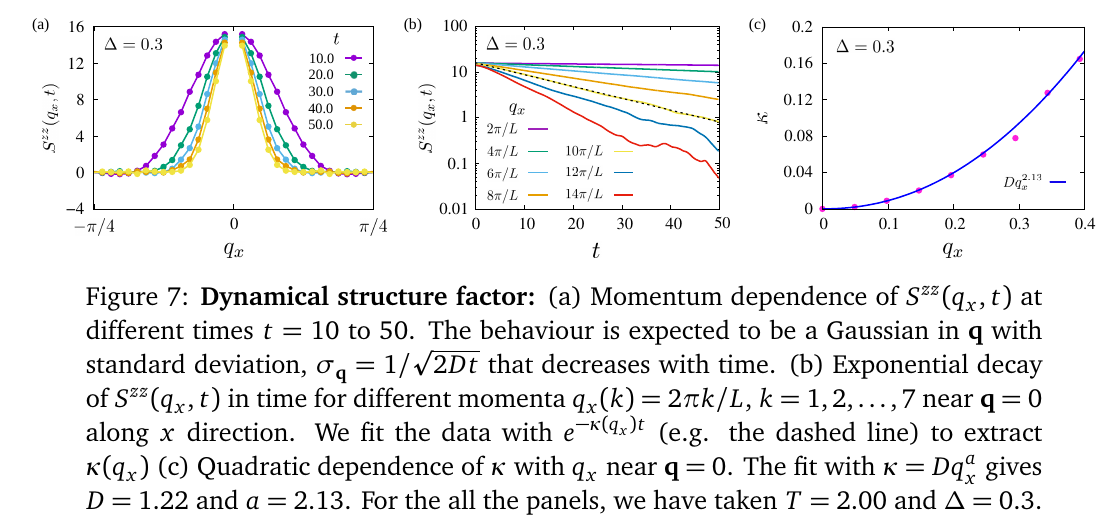
Figure 7: Dynamical structure factor: (a) Momentum dependence of S zz ( q different times t = 10 to 50. The behaviour is expected to be a Gaussian in q with (cid:112) = 1 / standard deviation, σ 2 Dt that decreases with time. (b) Exponential decay q ( k ) = 2 π k / L , k = 1,2,...,7 near q = 0 of S zz ( q , t ) in time for different momenta q x x along x direction. We fit the data with e − κ ( q x ) t (e.g. the dashed line) to extract κ ( q ) (c) Quadratic dependence of κ with q near q = 0. The fit with κ = Dq a x x